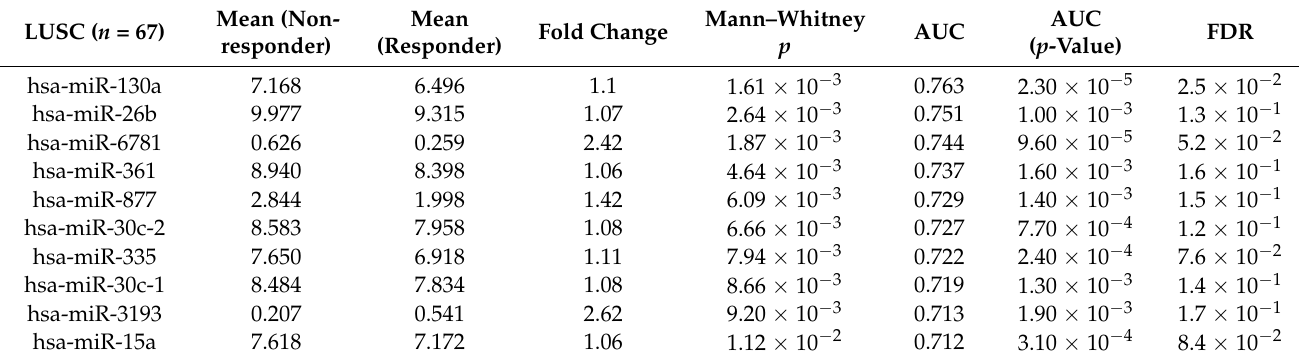
Table 4. Top ten miRNA biomarker candidates of platinum-based therapy in lung squamous carcinoma (LUSC). Mean LUSC ( n = 67)